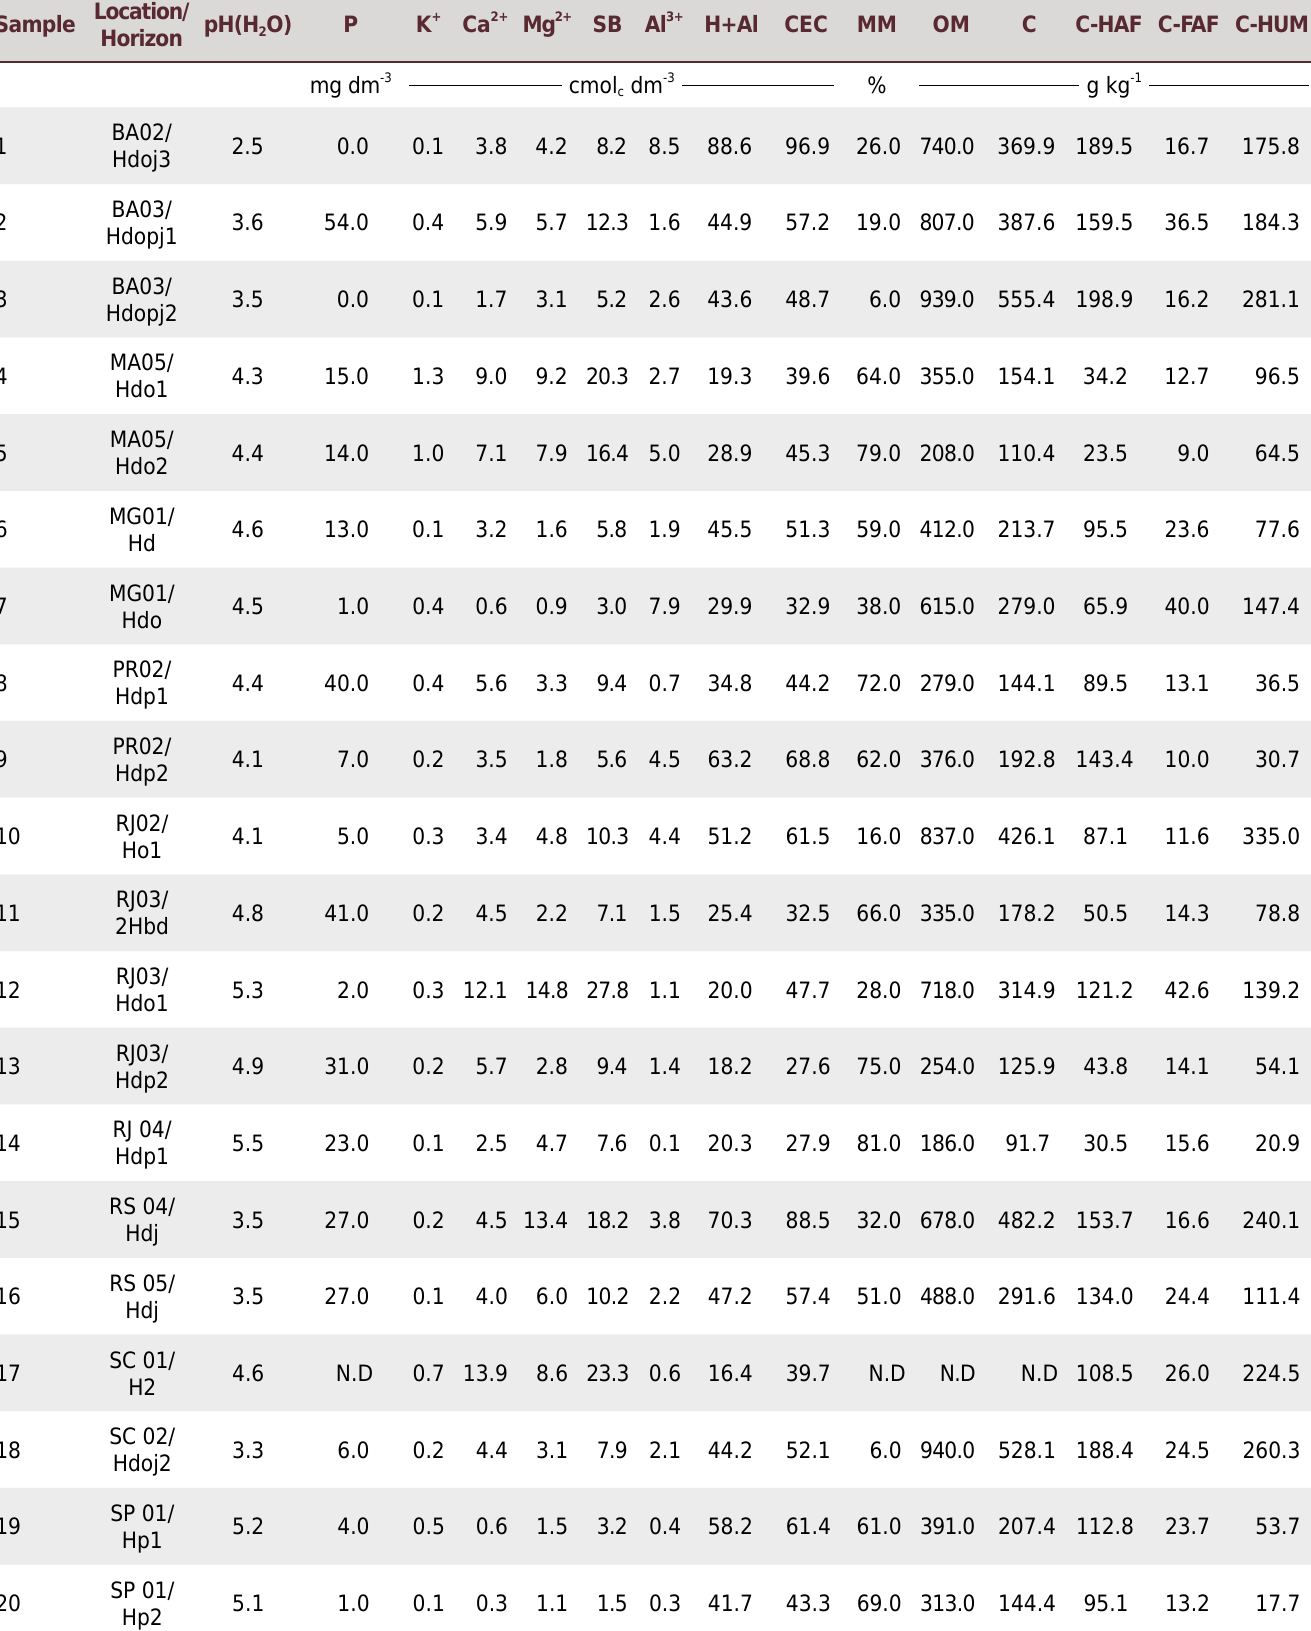
Table 1. Identification, chemical characterization and organic matter fractionation of the organic horizons Location/ Sample pH(H 2 Horizon